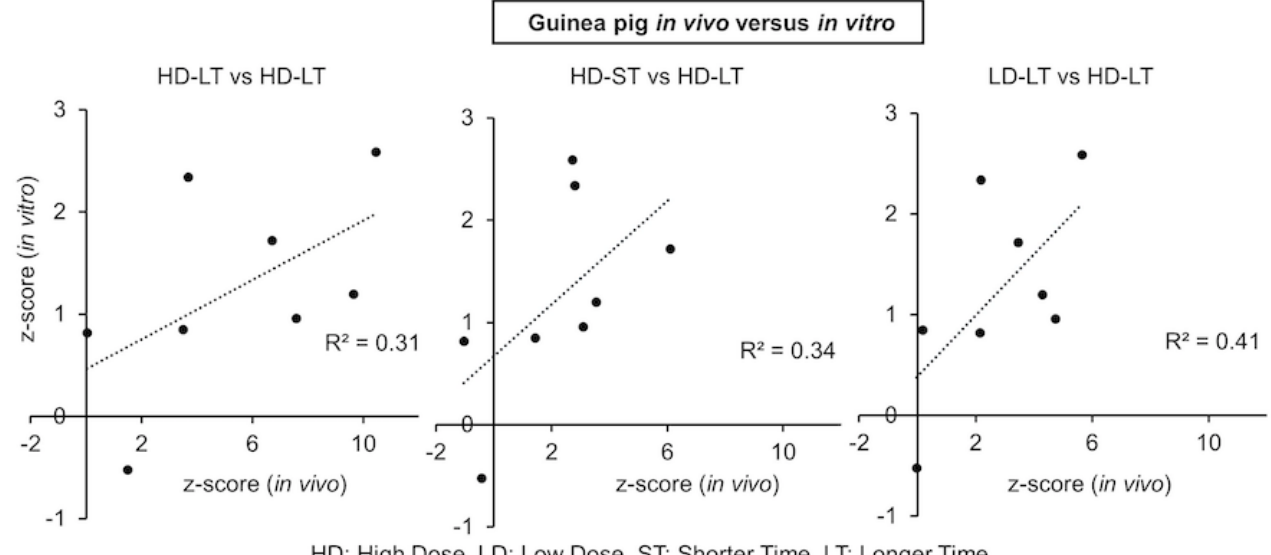
Figure 3. Correlation between kidney injury module scores for the in vivo versus in vitro guinea pig studies.